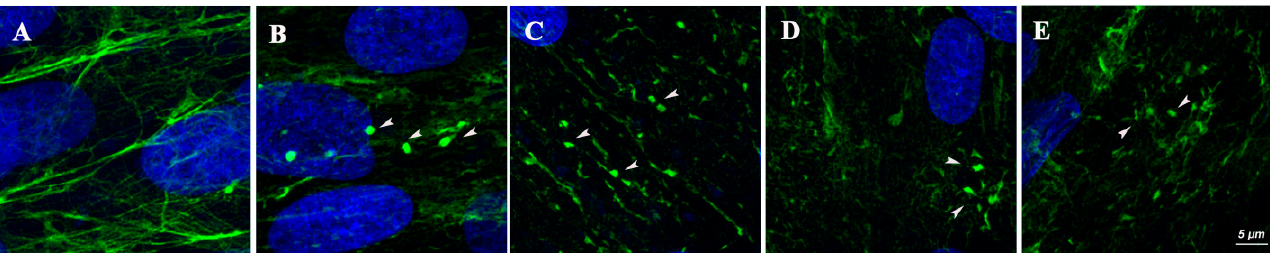
Figure 4. High-resolution images of the collagen VI extracellular matrix. Representative images (blue = nuclei, green = collagen VI matrix) of fibroblasts from healthy controls ( A ) and from the four individuals (1–4, B – E , respectively) showing collagen VI globular speckles (arrows), often connected by thin fibrils, a diffuse staining pattern and general fragmentation of collagen VI fibrils in individual samples compared with an organized network of fibers from a healthy control.